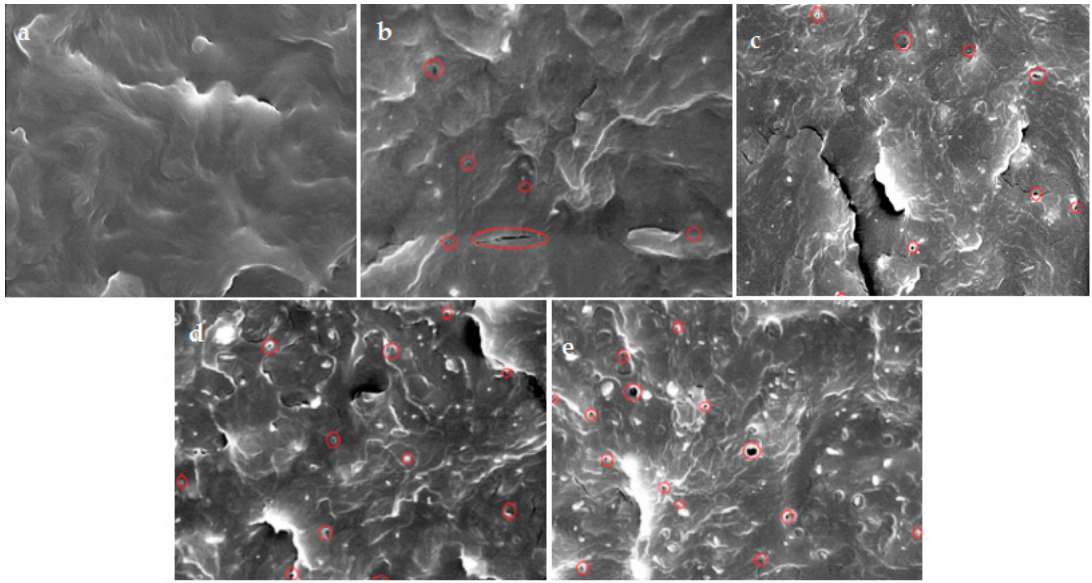
Figure 6. Scanning Electron Microscopy (SEM) of the nanocomposites ′ fractured surface for neat PBS and PBS-HNT-based; ( a ) PBS0: neat PBS; ( b ) PBS1: PBS + 1 wt % HNT loading; ( c ) PBS3: PBS + 3 wt % HNT loading; ( d ) PBS5: PBS + 5 wt % HNT loading; and ( e ) PBS7: PBS + 7 wt % HNT loading; PBS: Poly(Butylene Succinate) [80].